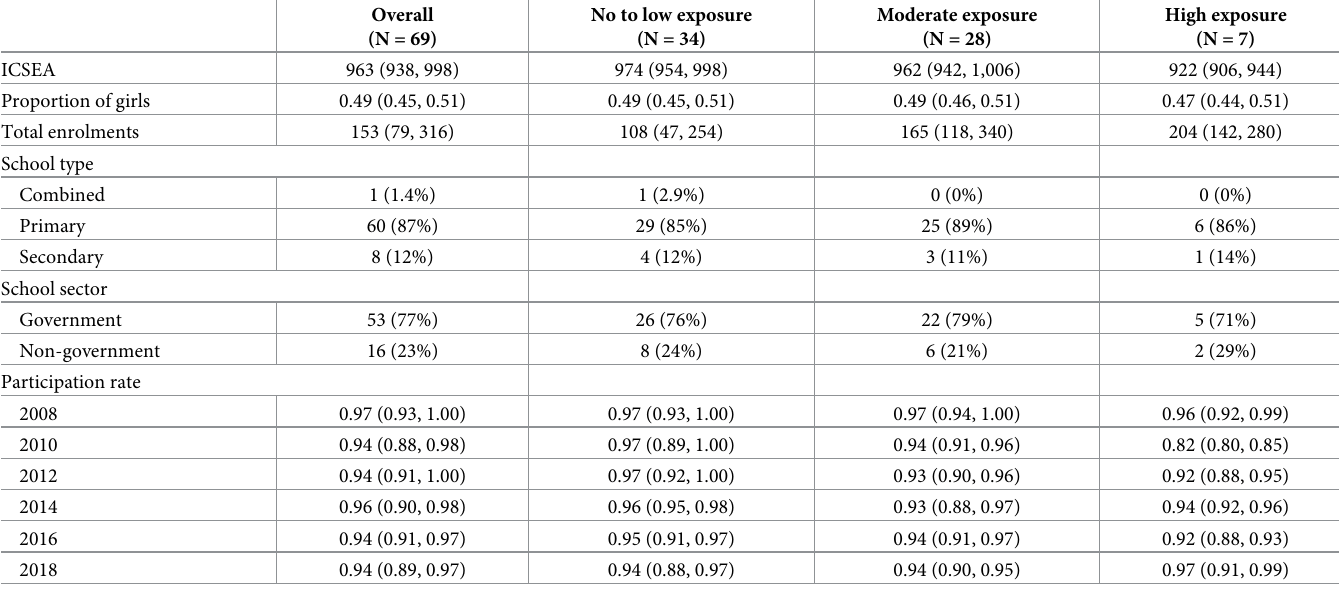
Table 1. School profile (in the year 2014) and NAPLAN participation rate by exposure